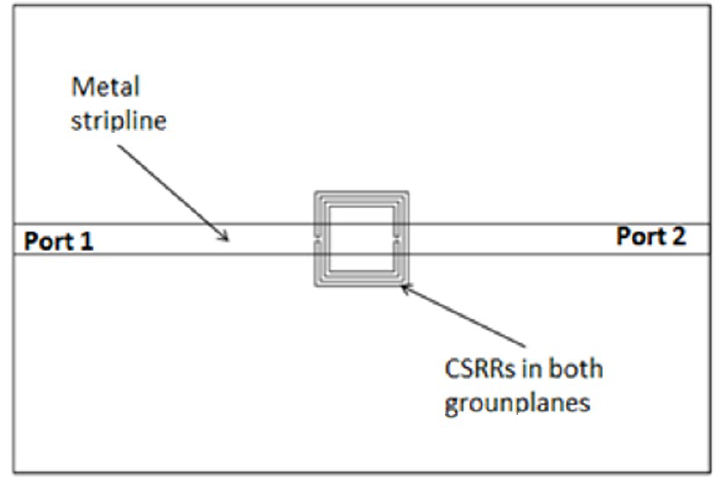
Figure 2. Top layout stripline loaded with SCSRR elements embedded in the top and bottom layers.